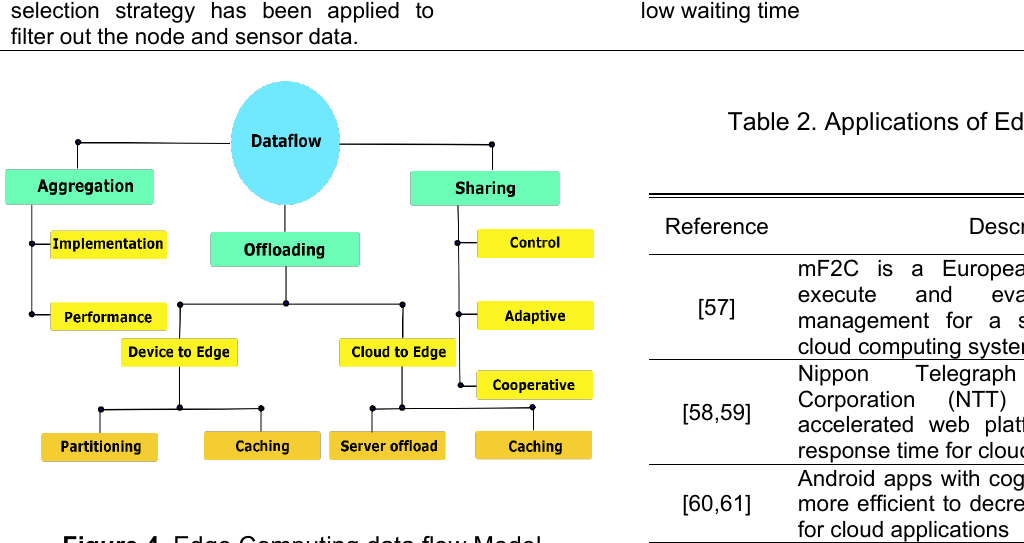
Figure 4. Edge Computing data flow Model